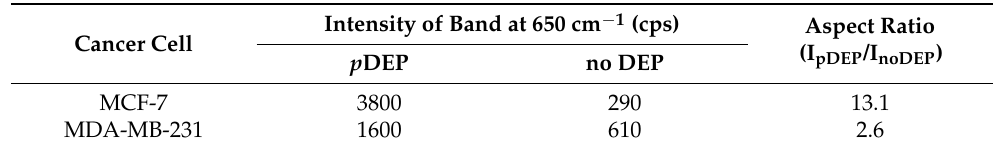
Table 3. Summary of efficiency of deposition of the CTCs (applied pDEP and spontaneous, gravita- tional deposition—no DEP) calculated for intensity of marker band at 650 cm − 1 .